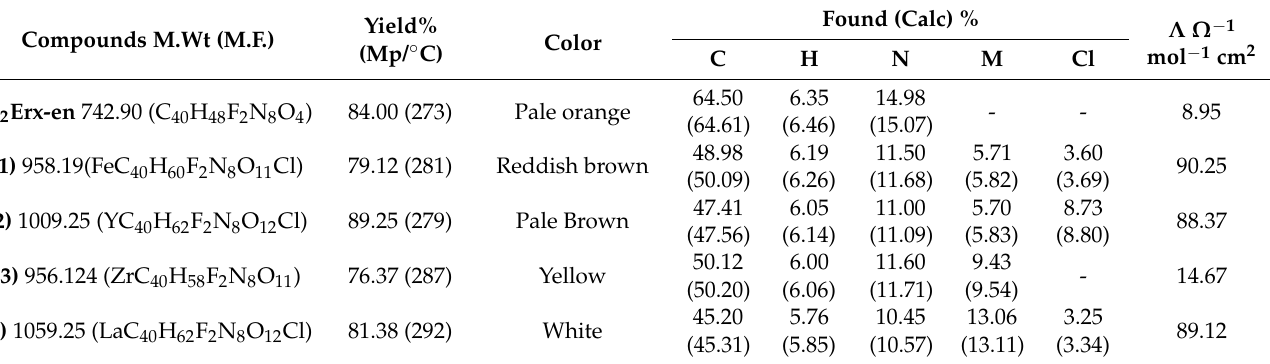
Table 1. Elemental analysis and physico-analytical data for H 2 Erx-en and its metal complexes. Yield% Compounds M.Wt (M.F.) (Mp/ ◦ C)